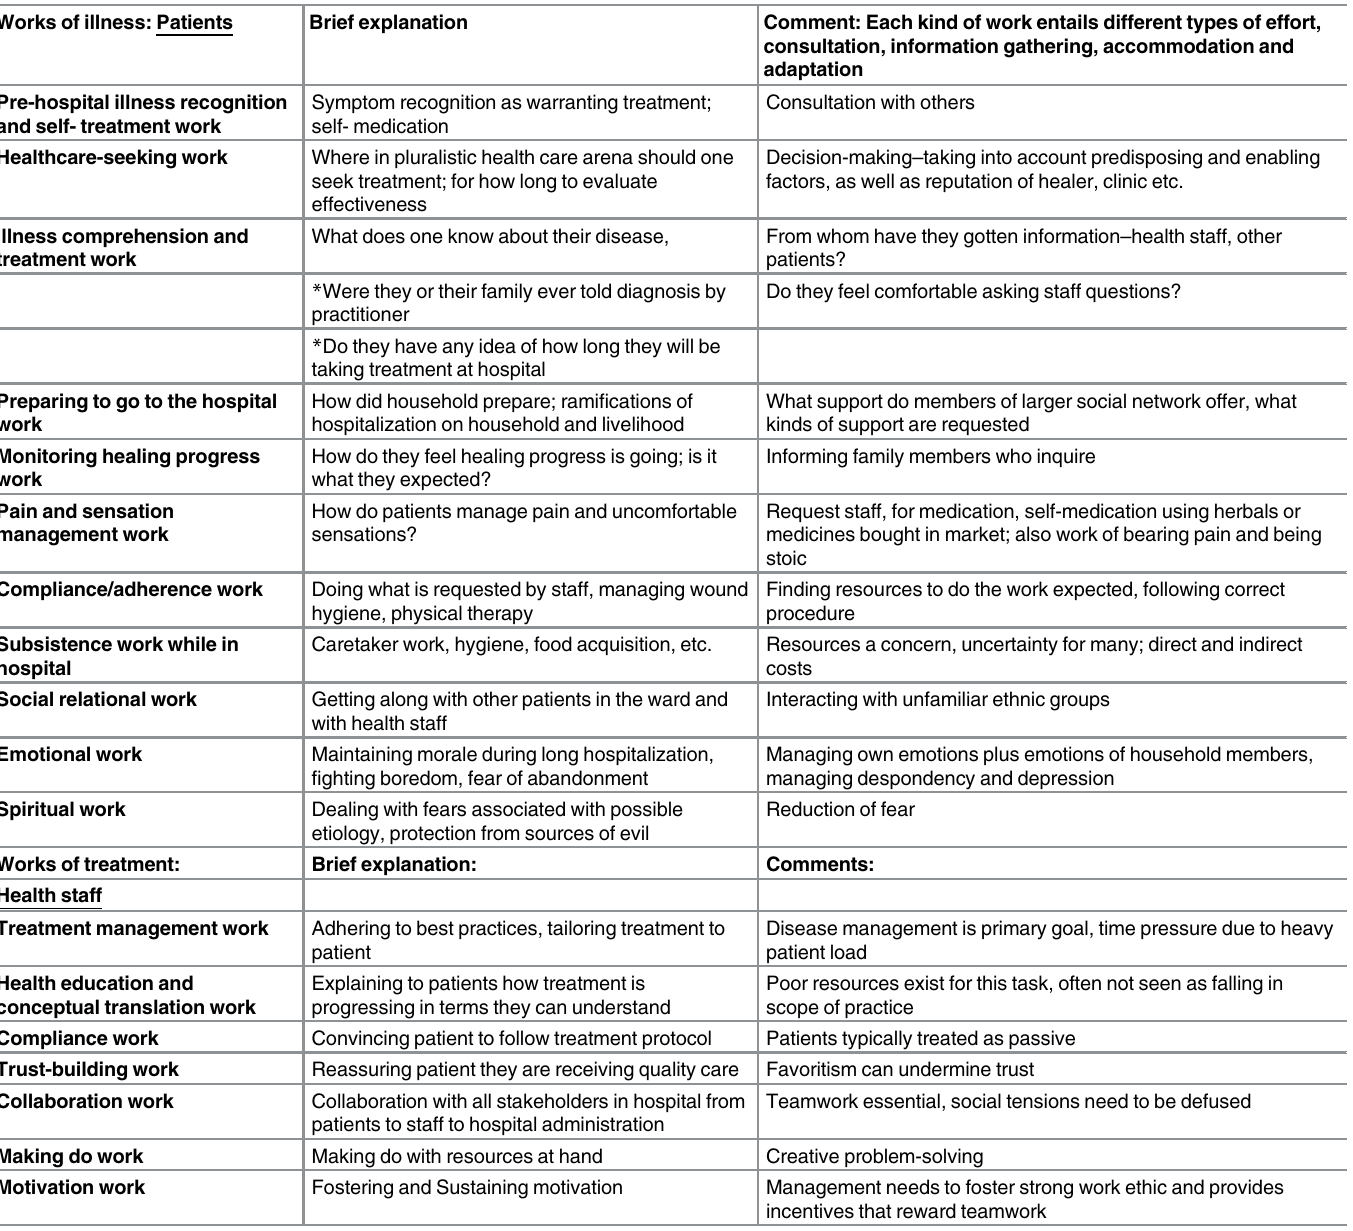
Table 2. Key works of illness and treatment for ulcer patients and health staff (adapted from Corbin and Strauss 1985 [13]); Nichter 2005